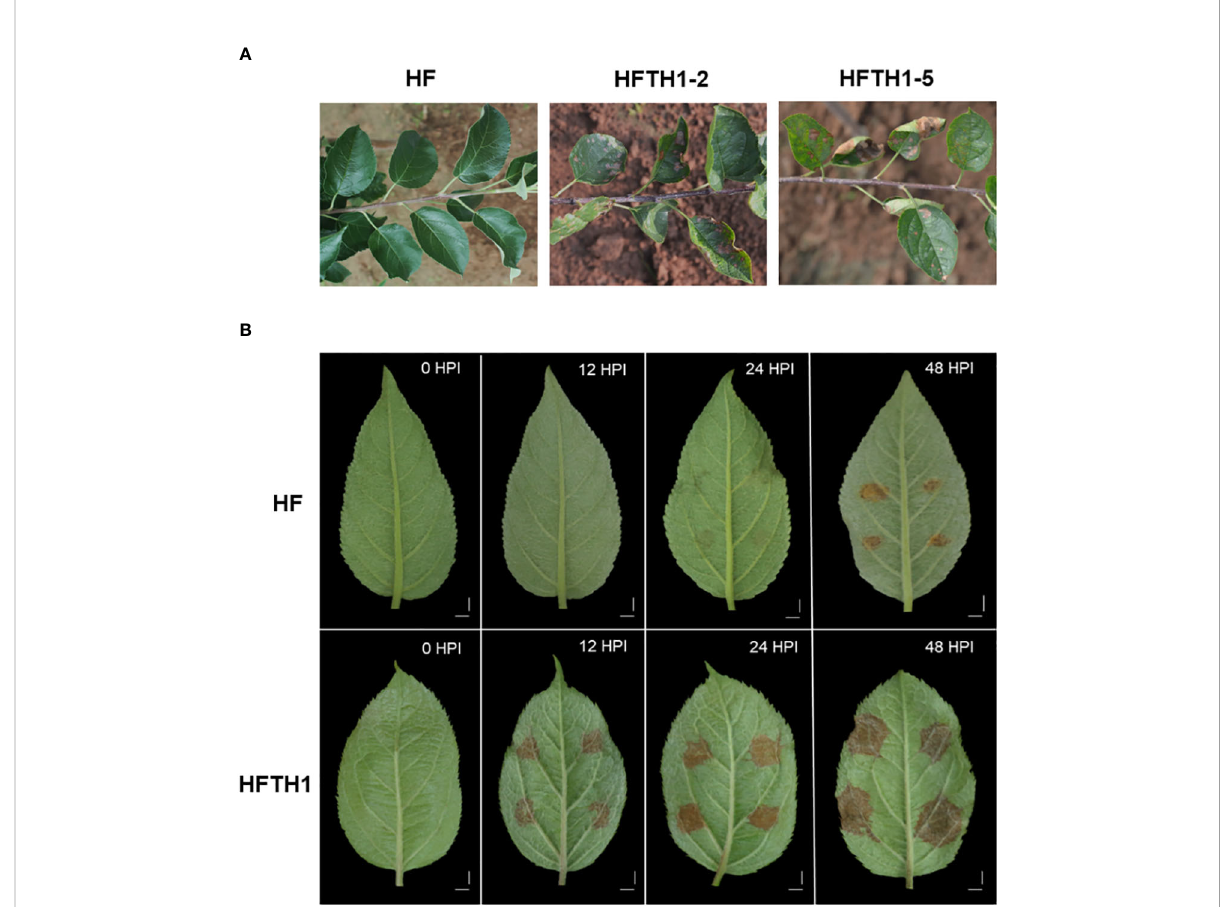
FIGURE 1 Different susceptibility of HF and HFTH1 to AAAP. (A) Investigation of the susceptibility of HF and HFTH1 to AAAP in the fi eld experiments. (B) Changes in symptoms of HF and HFTH1 at 12, 24, and 48 h after inoculation with AAAP in vitro . Mock inoculation of HF and HFTH1 leaves without AAAP was used as the control (0HPI). Scale bar = 1